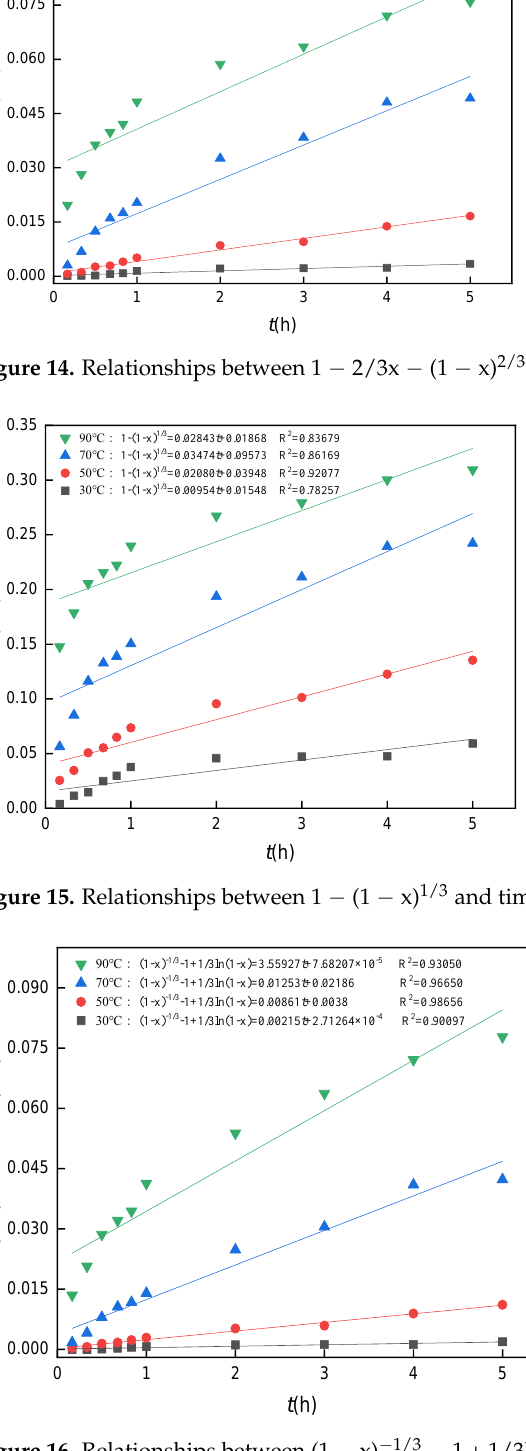
Figure 16. Relationships between (1 − x ) − 1/3 − 1 + 1/3ln(1 − x ) and time of aluminum ions.